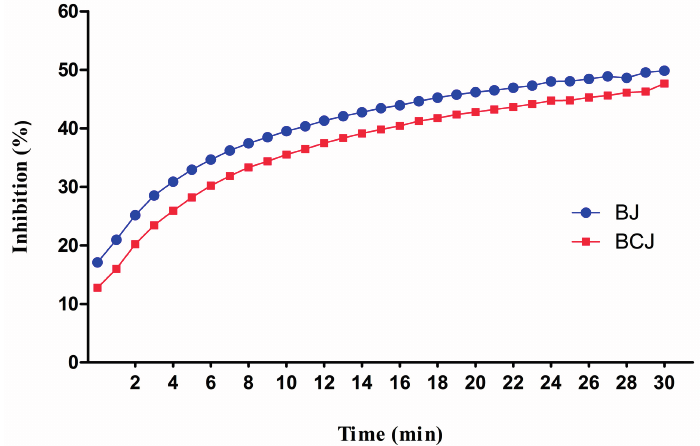
Figure 2. Antioxidant potency of blueberry (BJ) and blackcurrant (BCJ) juices using DPPH method. The inhibition percentage represents the antioxidant